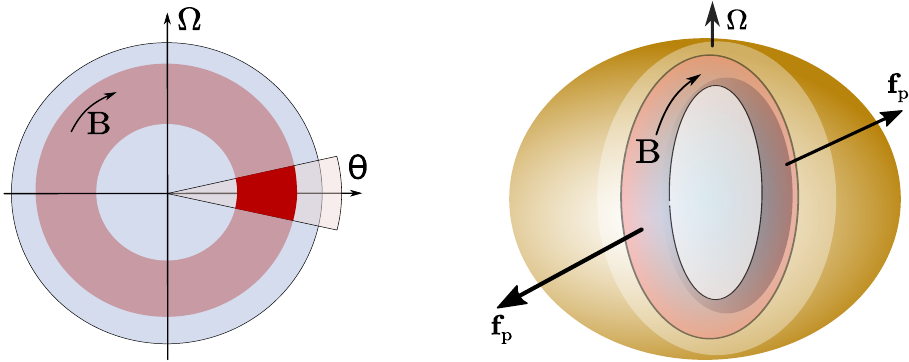
Figure 1. Left: Lateral view of our simplified configuration, in which the neutron star has been sliced along the vertical plane containing the toroidal magnetic field region (its width goes from about 0.4 R ∗ to 0.8 R ∗ ). The two axes are the rotation axis of the neutron star aligned with the angular velocity Ω and the ( θ = π /2, φ = 0), while the dark red region corresponds to the strong pinning region as indicated in the text. Right : Cartoon of the triaxial deformation induced by the presence of pinned vortices in the two (diametrically opposed) strong pinning regions. For perfect pining, the force f p in (7) is directed outwards when the superfluid spins faster than the normal component. Both sketches are not to